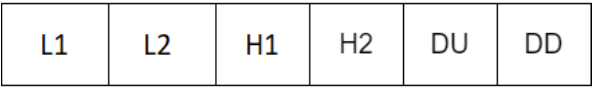
Figure 2. The structure of one vector of